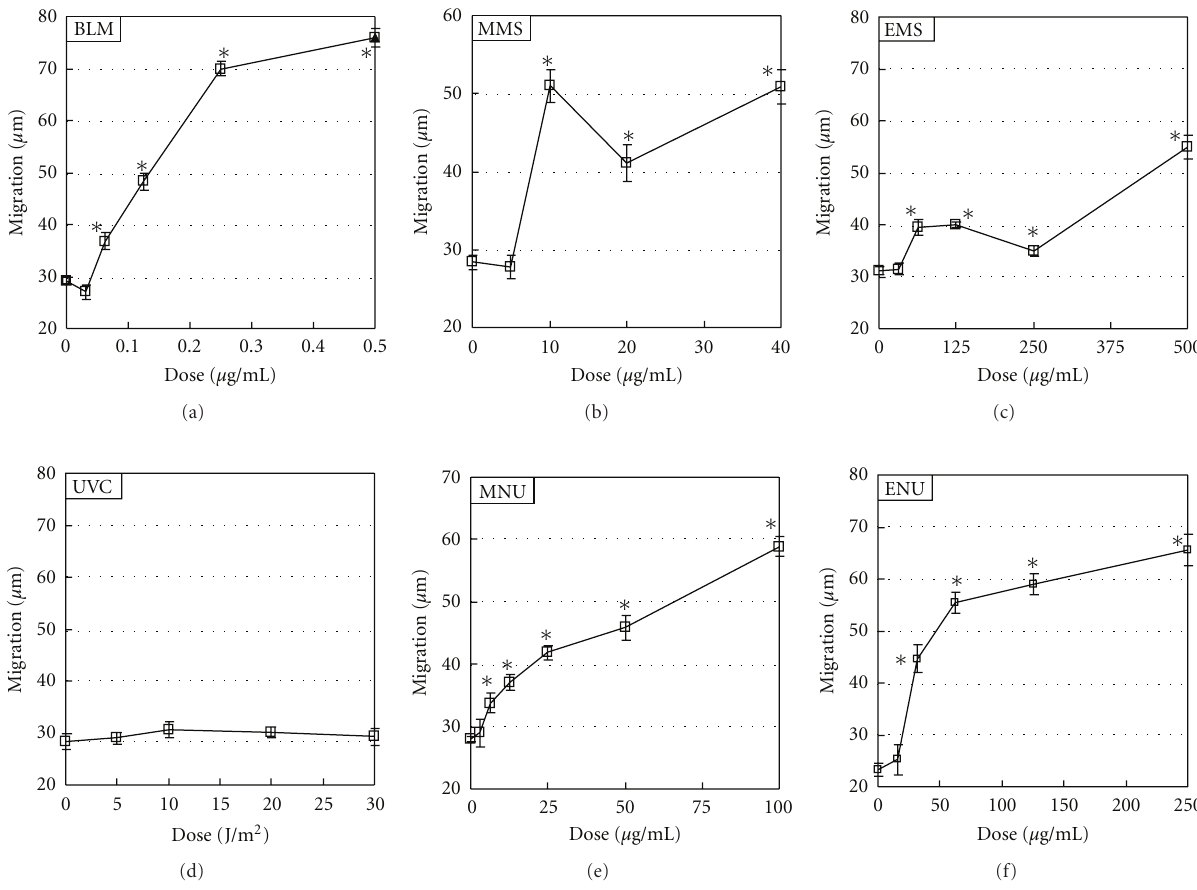
Figure 2: Acellular assay in TK6 cells. Slides for Comet assay were exposed to each chemical mutagen for 2h or irradiated with UVC, and then electrophoresis was conducted at pH > 13 immediately after exposure to the chemical mutagen or 2h after UVC irradiation. Reproducibility was ascertained by three independent experiments and representative data are shown. The error bars indicate standard errors of the mean. ∗ Significant di ff erence from untreated control: P < .